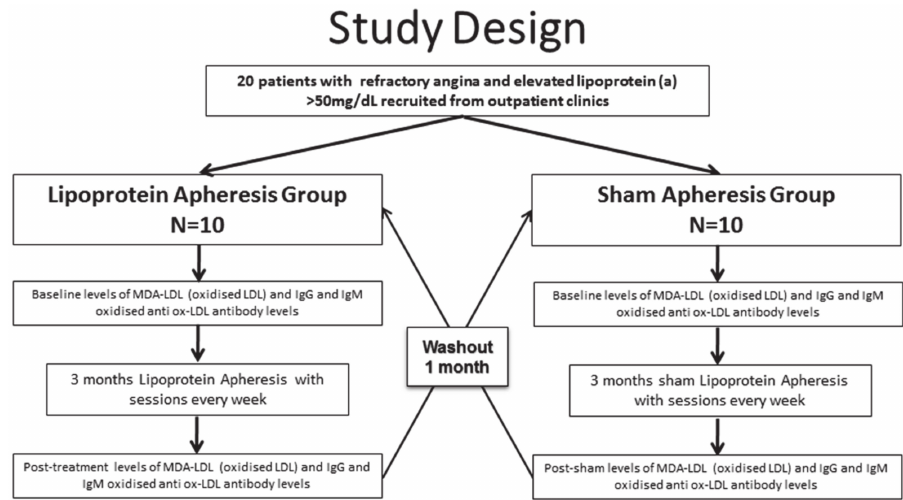
Figure 1. Flow chart summarising the trial